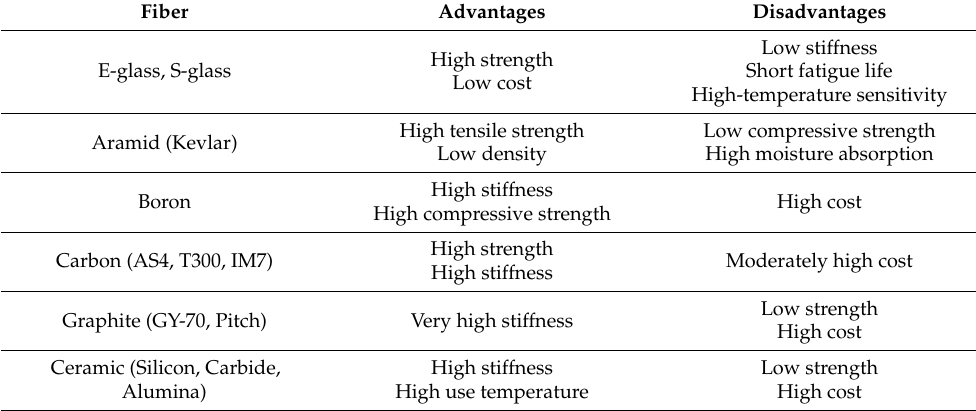
Table 1. Advantages and disadvantages of reinforcing fibers (adapted with permission from Ref. [1]).